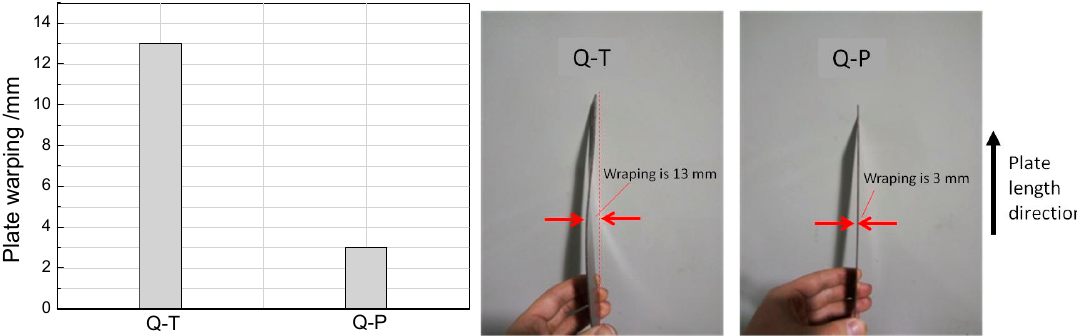
Figure 9. The plate has a better flatness by Q-P treatment than by Q-T treatment. The plate size is 1.5 mm (thickness) × 80 mm (width) × 250 mm (length).